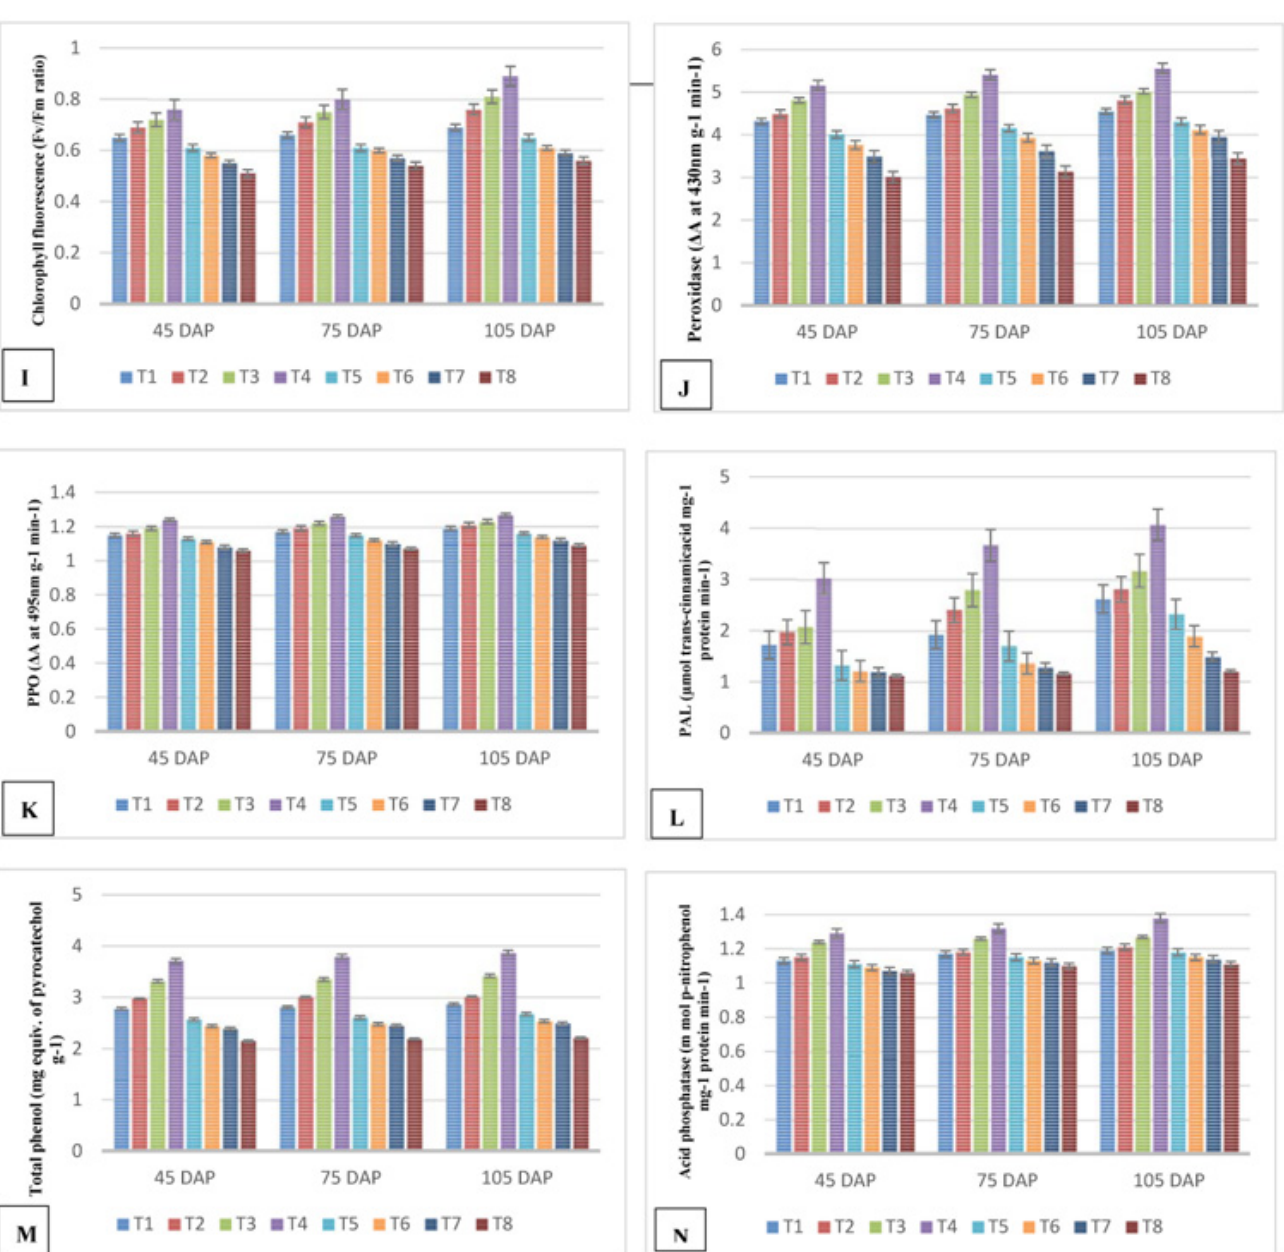
Figure 2. Influence of different plant growth regulators in guava infected by M. enterolobii at 45, 75, and 105 days after planting: ( A ) plant height; ( B ) root length; ( C ) fresh root biomass; ( D ) dry root biomass; ( E ) chlorophyll index; ( F ) photosynthetic rate; ( G ) transpiration rate; ( H ) stomatal conductance; ( I ) chlorophyll fluorescence; ( J ) peroxidase; ( K ) polyphenol oxidase; ( L ) phenylalanine ammonia lyase; ( M ) total phenols; ( N ) acid phosphatase.